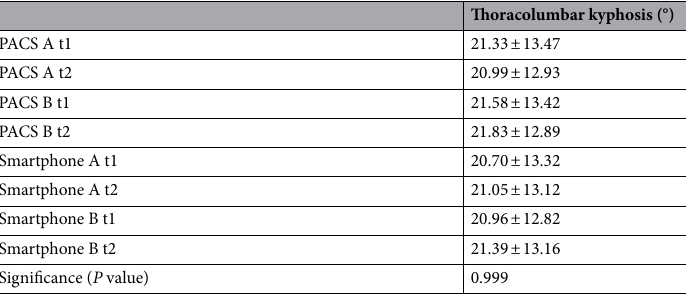
Table 1. Mean ± SD values of all measurements and their comparison. P values indicated the significance between the values in the same column. PACS A t2: the results of the second time of observer A using PACS, and so on. Smartphone B t1: the results of the first time of observer B using smartphone, and so on.